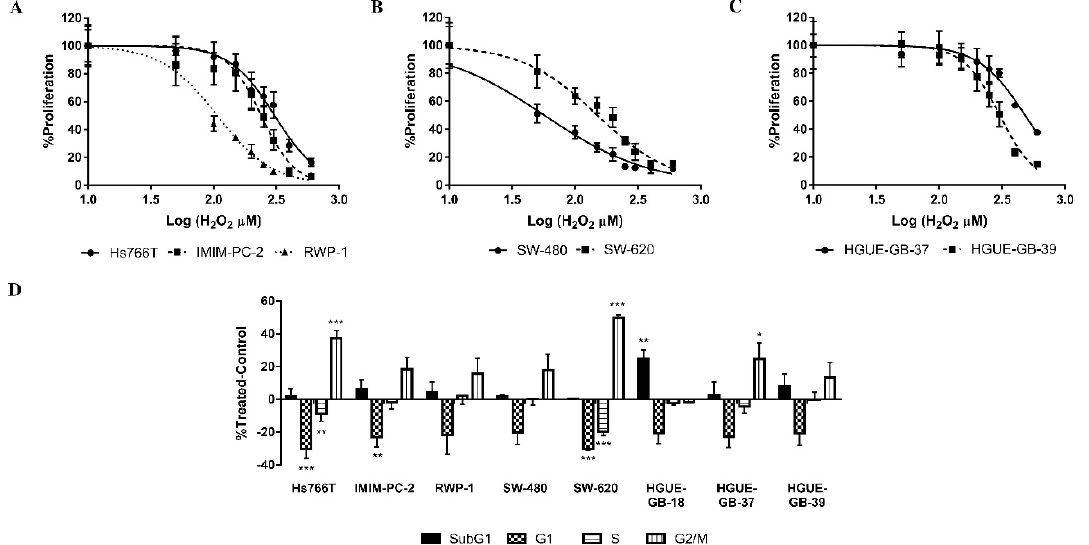
Figure 8. H 2 O 2 effect in pancreatic carcinoma, colorectal carcinoma, and glioblastoma cell models. H 2 O 2 anti-proliferative effect induced in pancreatic carcinoma ( A ), colorectal carcinoma ( B ) and glioblastoma ( C ) cell lines. Cells were treated with H 2 O 2 , in a concentration range between 50–600 µ M for 72 h and cell proliferation was determined by MTT assay. Graph shows the proliferation percentage ± SD respect to control untreated versus the logarithm of the concentration ( n ≥ 6). ( D ) Variations in cell cycle distribution after H 2 O 2 treatment in Hs766T, IMIM-PC-2, and RWP-1 pancreatic carcinoma cell lines, SW-480 and SW-620 colorectal carcinoma cell lines and HGUE-GB-18, HGUE-GB-37, and HGUE-GB-39 glioblastoma cell lines. Cells were treated with 600 µ M H 2 O 2 for 24 h and cell cycle distribution was determined by flow cytometry. Graph shows the cells percentage ± SD in each phase of cell cycle after subtracting the cells percentage in the control untreated ( n ≥ 3). * indicates a p -value < 0.05, ** < 0.01 and *** < 0.001. Table 3. IC50 value of H 2 O 2 on pancreatic carcinoma (PC), colorectal carcinoma (CRC) and glio- blastoma (GBM) cell lines. Cells were treated with a concentration range between 50 and 600 μ M H 2 O 2 for 72 h. Origin